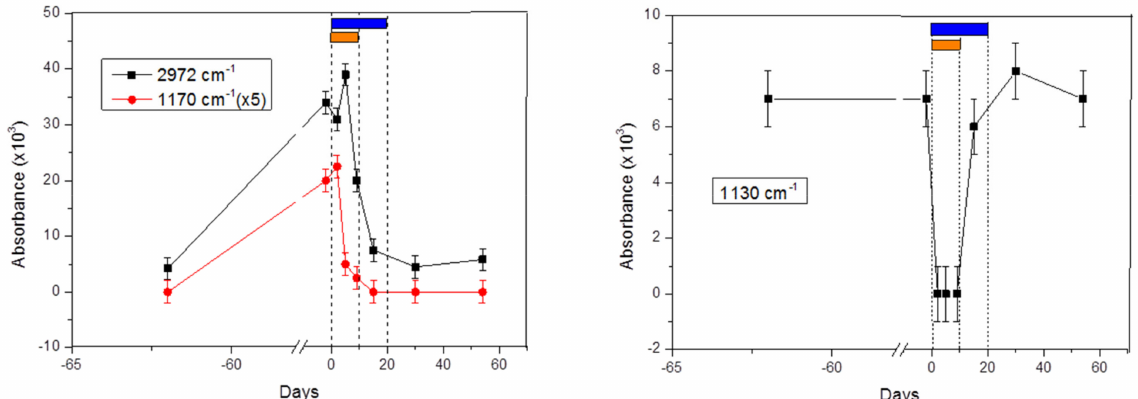
Figure 1. Absorbance variation (proportional to the concentration variation) of three spectral structures centered at 2972 cm − 1 , 1170 cm − 1 ( left ), and 1130 cm ß1 ( right ) caused by QAC. The lines connecting the data points are used for better visibility. Vertical dash lines show the start of the QAC course (left line), the end of the antibiotic course (middle line) and the end of the probiotic course. The corresponding bars indicate the same: orange horizontal bar shows the antibiotic treatment in frame of QAC whereas blue bar—Omnibiotic 10 course taken in parallel to QAC. Absorbances at − 62 and 58 days at the plots correspond to the steady state level of the corresponding VOC. Data points corresponding to dates earlier than − 60 and longer than 60 days were collected and used only for analysis; they are not presented here in order to improve the visibility of the